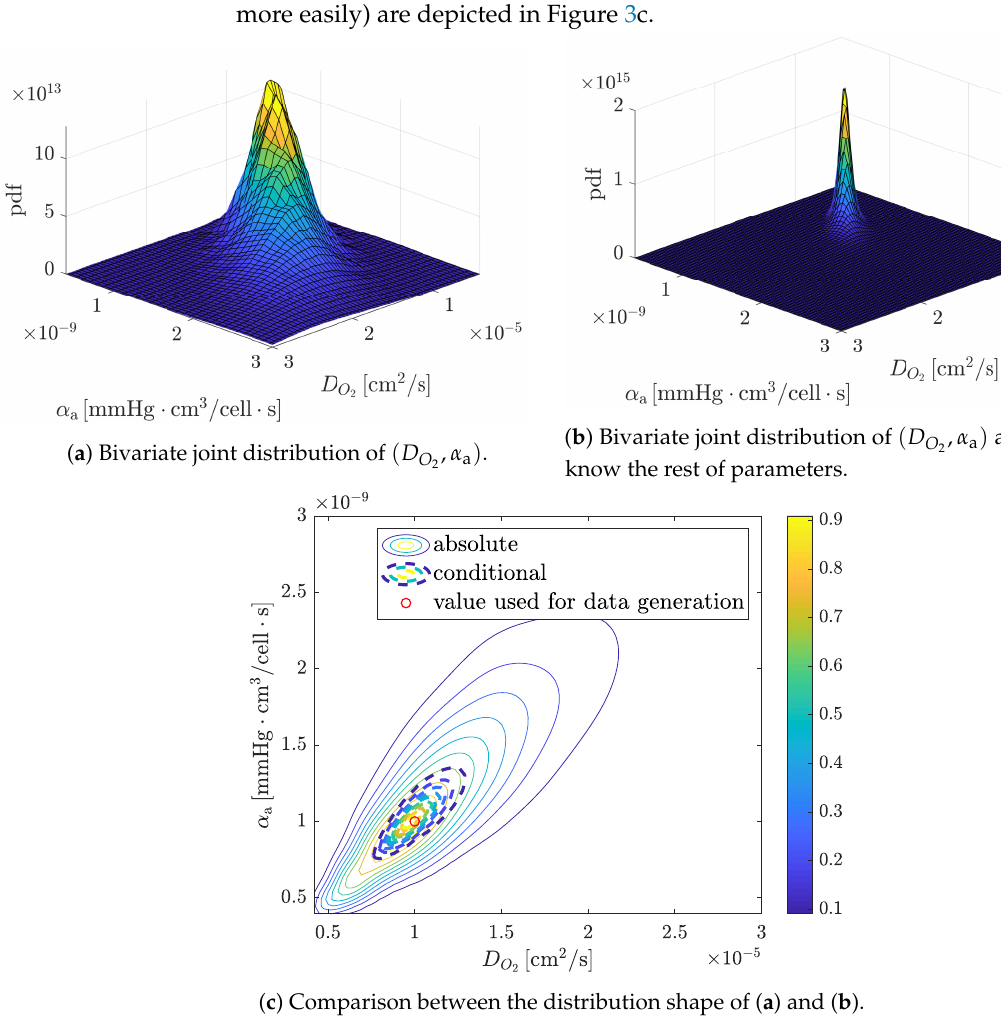
Figure 3. Bivariate joint distribution functions of D O